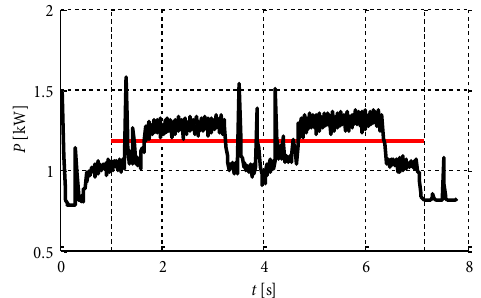
Fig. 12. Waveform of additional power loss of the model and average power on corners